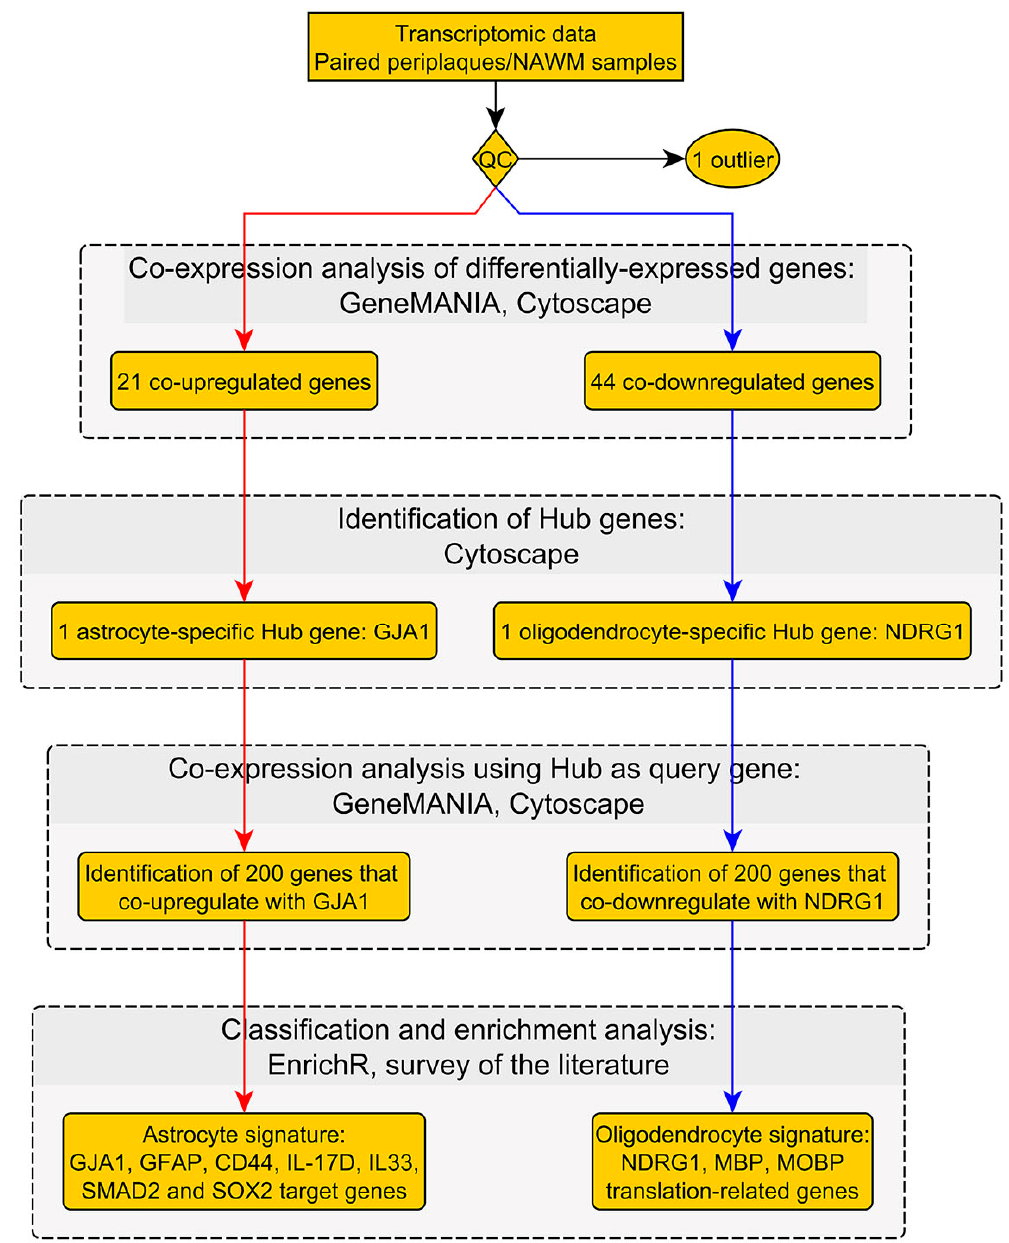
Figure 1. Workflow No. 1.